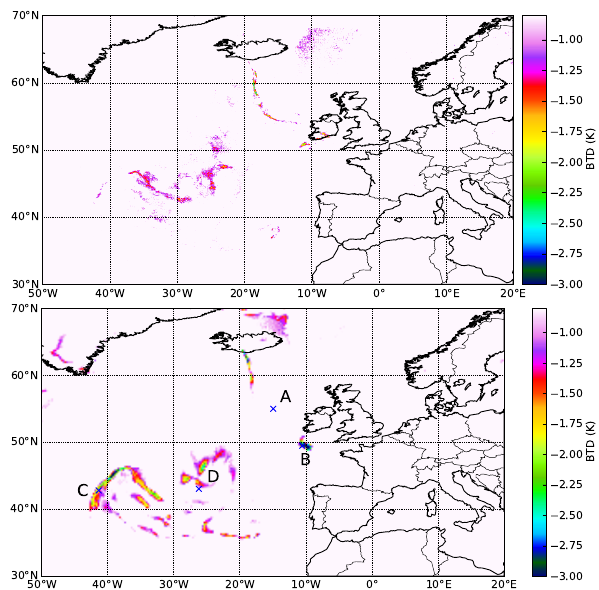
Fig. 7. Pixels identified as ash by the inverse absorption technique. Top panel: the SEVIRI 10.8–12.0µm channels brightness tempera- ture difference. Bottom panel: the simulated 10.8–12.0µm channels brightness temperature